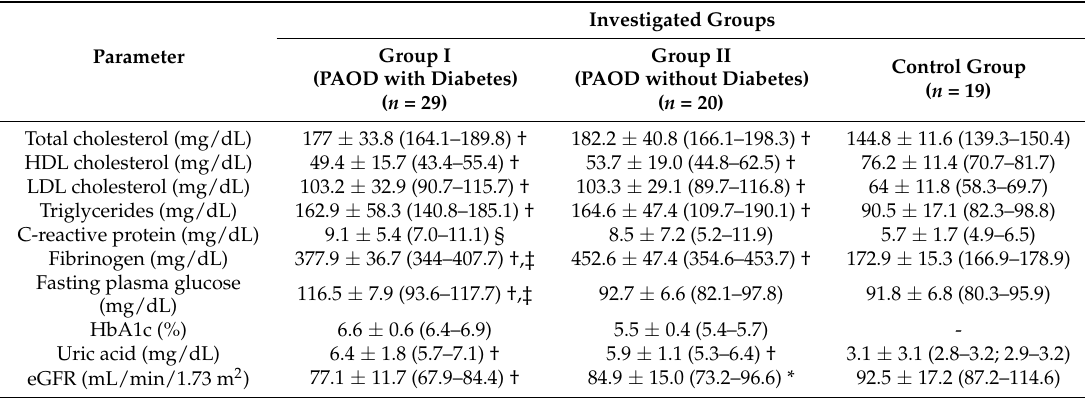
Table 2. Biochemical parameters in patients with peripheral arterial occlusive disease of the lower